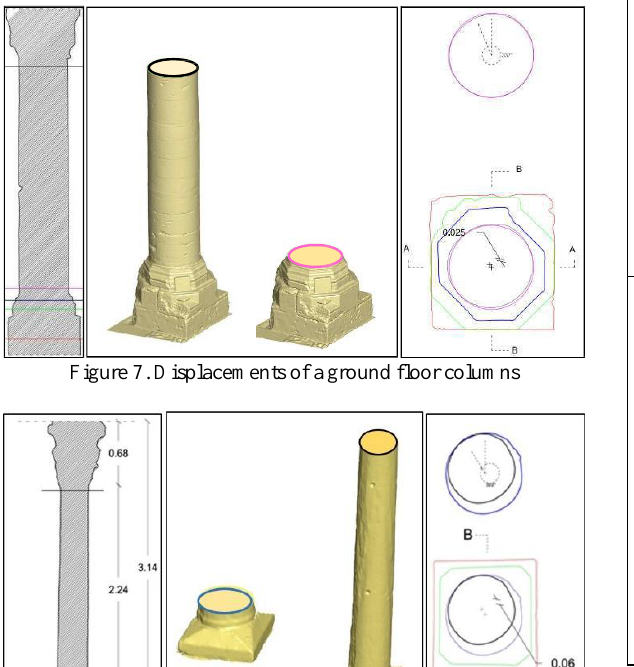
Figure 10. Representation of the ground floor plan and